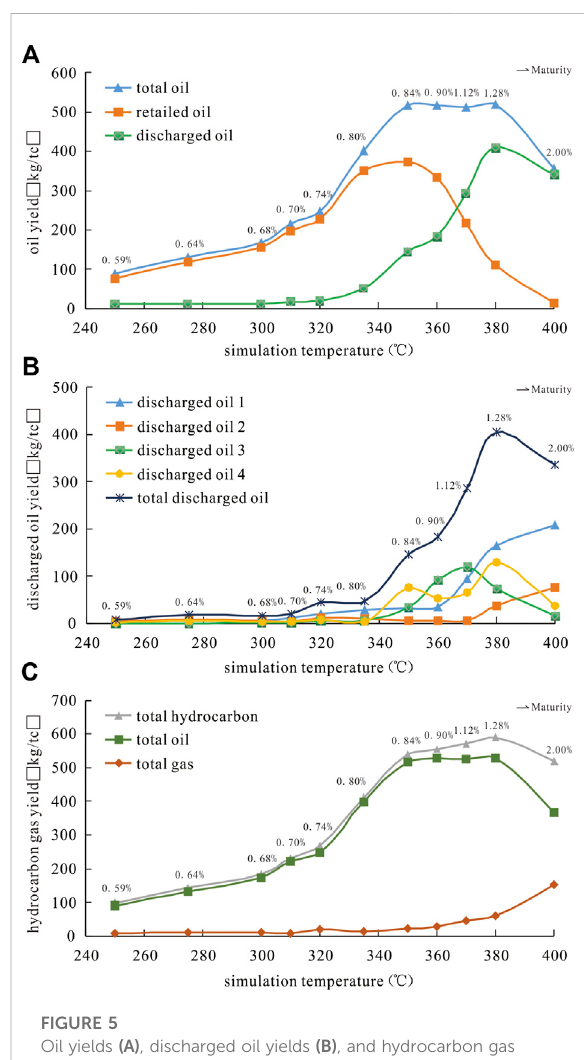
FIGURE 5 Oil yields (A) , discharged oil yields (B) , and hydrocarbon gas yields (C) of shale with a silty interlayer (model